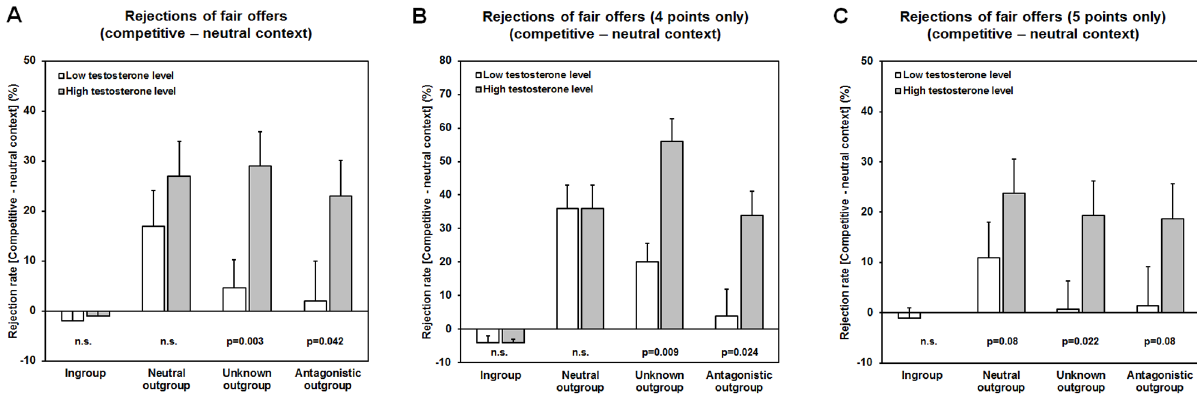
Figure 4. Endogenous testosterone influences modulates behavioral adaptations between contexts. (A) Subjects with high testosterone levels exhibited a significantly stronger increase in the number of rejections of fair proposals, when these were made by a member of the unknown or the antagonistic outgroup (behavioral adaptation between neutral and competitive context). (B) and (C) This was also the case when examining the offer values of 4 and 5 points